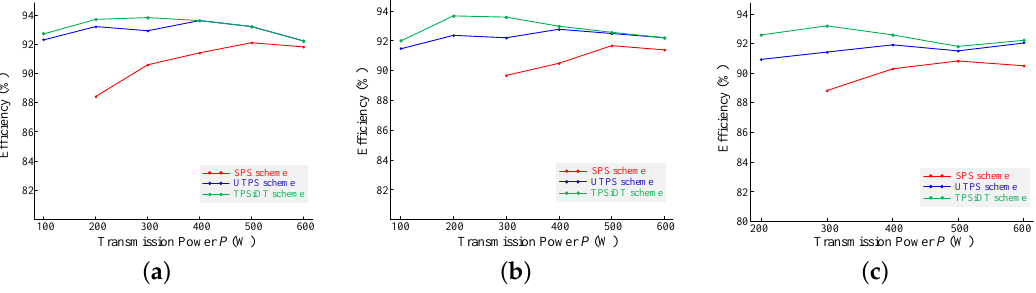
Figure 23. Efficiency curves versus the transmission power P : ( a ) M min = 0.04; ( b ) M min = 0.1; and ( c ) M min = 0.15.